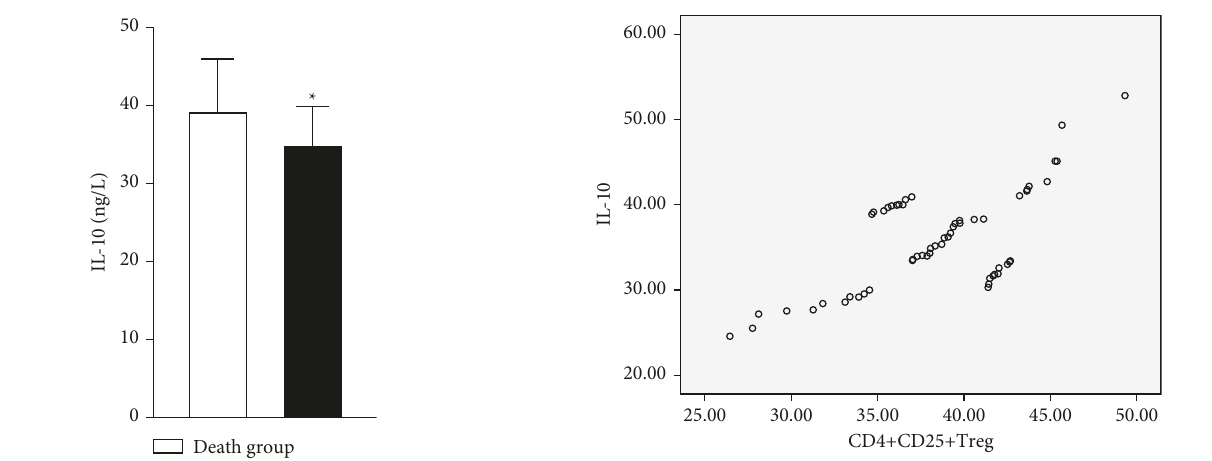
Figure 4: Relationship between CD4 +CD25 +Treg and